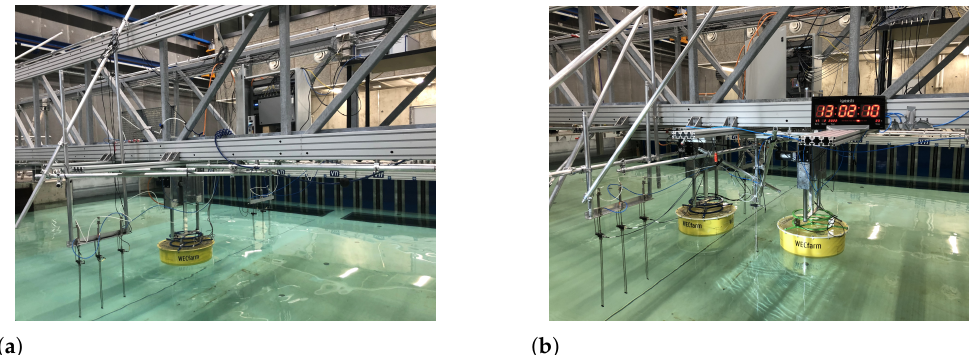
Figure 22. “WECfarm” experimental setup at the Aalborg University wave basin:( a ) single WEC (April 2021); ( b ) two WEC array (February